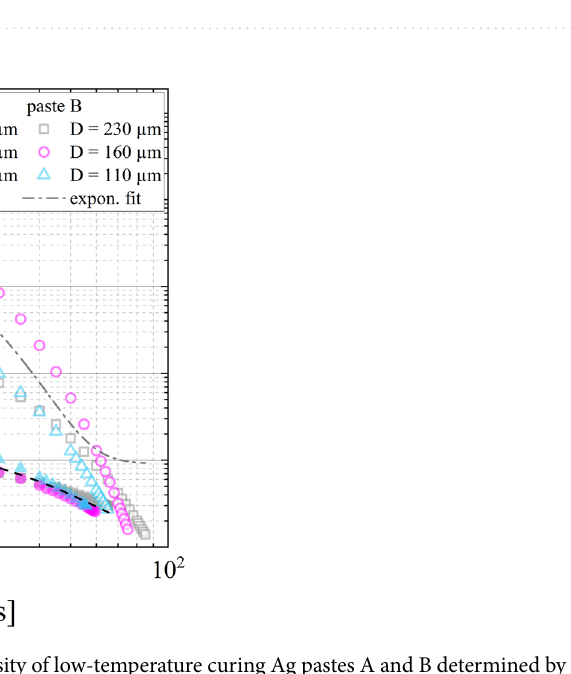
Figure 4. Necking of free-hanging extruded paste threads of pastes A and B. The mean thread diameter D thread is plotted over time t for nozzle diameters of D = 230 µm, D = 160 µm and D = 110 µm. The curves show an exponential evolution.